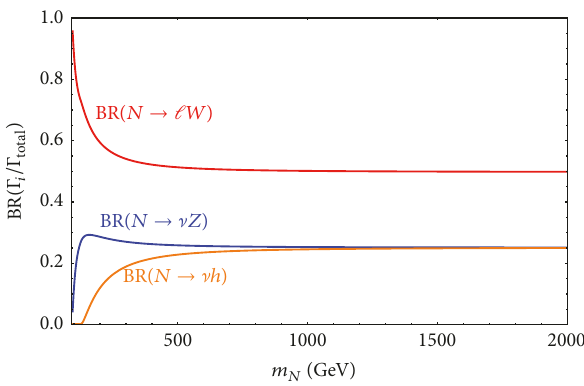
Figure 1: Heavy neutrino branching ratios ( BR 𝑖 ) for different decay modes are shown with respect to its mass (𝑚 𝑁 ) [51].